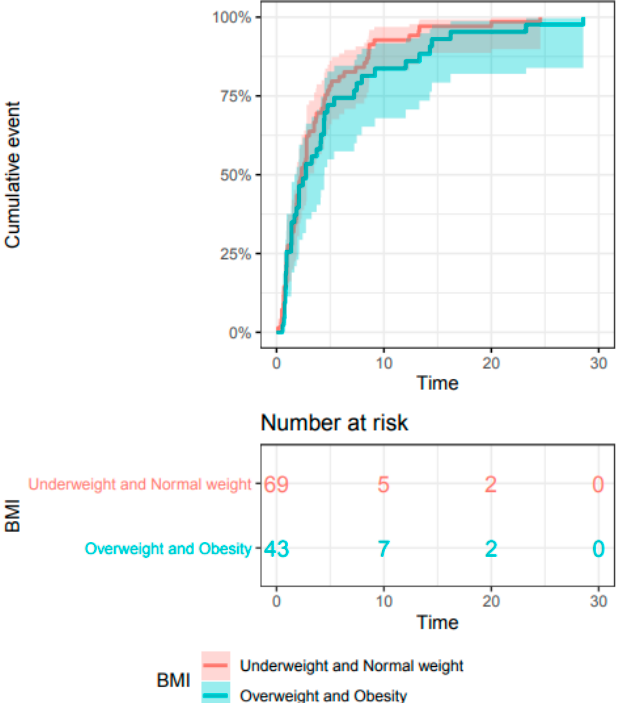
Figure 2. Kaplan–Meier estimate of time to toxicity in the whole population, by BMI category ( n = 272).